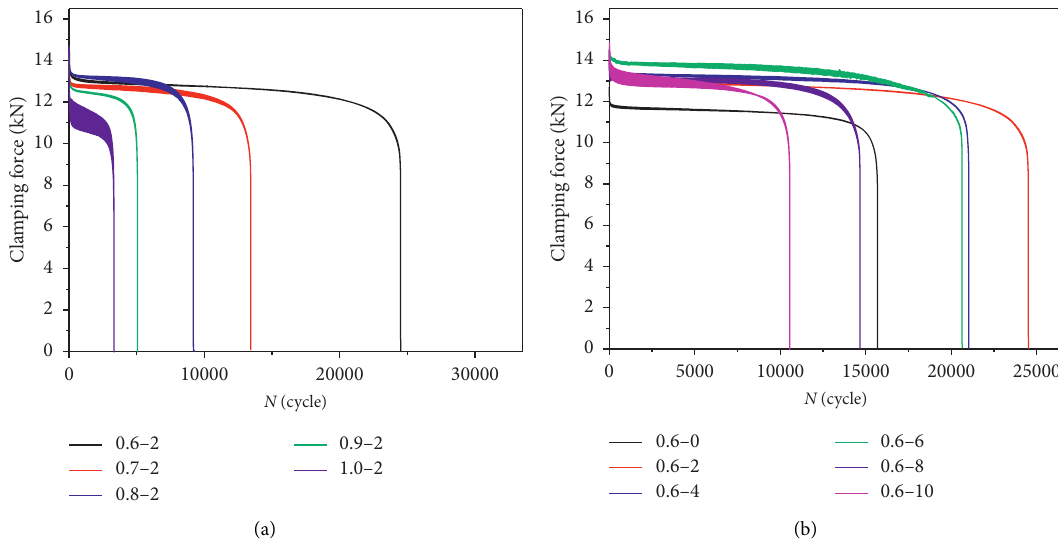
Figure 5: Comparison of clamping force recession curves under different loads: (a) under the same axial load and (b) under the same transverse